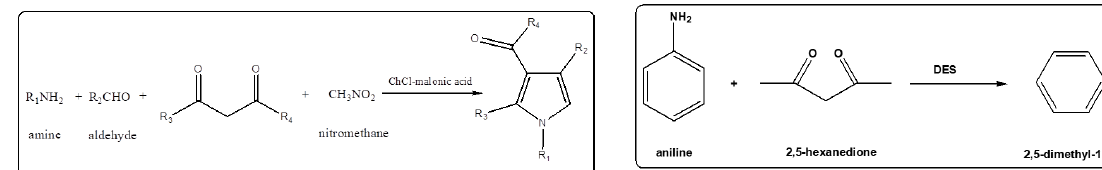
Figure 25: DES catalyzed synthesis of functionalized pyrroles. s s See Hu et al. [38] for detailed reaction components and conditions.